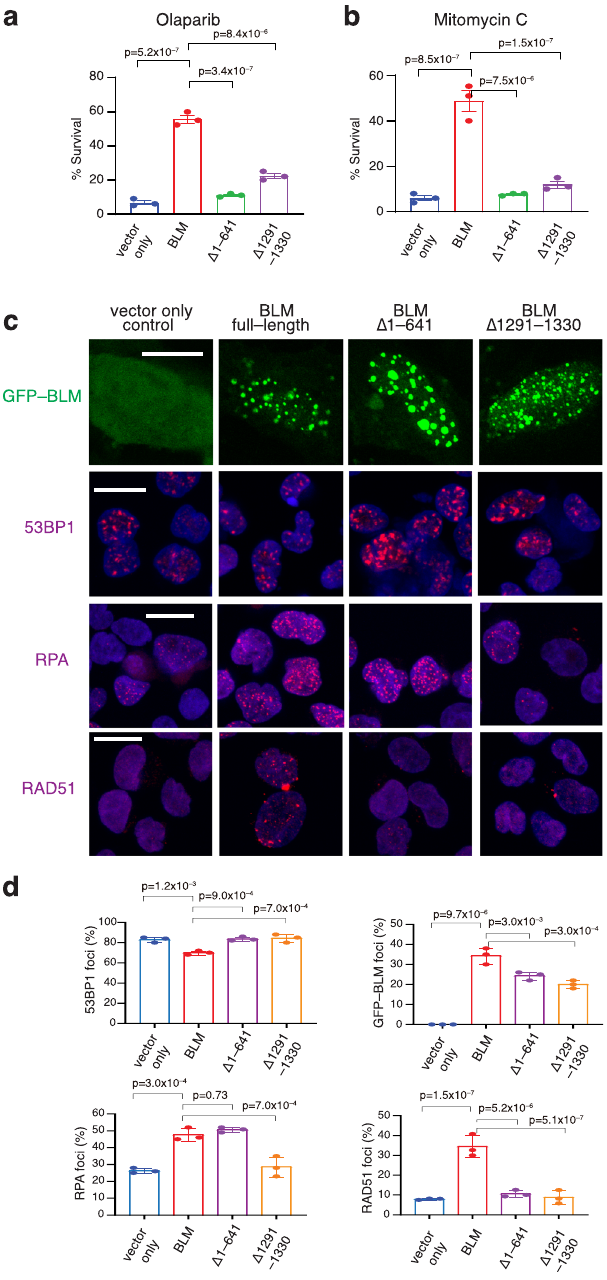
Fig. 7 DNA repair foci defects in cells expressing BLM Δ 1 – 641 and BLM Δ 1291 – 1330 . a Clonogenic survival assays for U2OS cells following double siRNA knockdown of BLM and EXO1 expressing either no BLM (vector only control), full-length GFP-BLM, GFP-BLM Δ 1 – 641 or GFP- BLM Δ 1291 – 1330 , as indicated, after treatment with 17 nM Olaparib (the IC50 for U2OS cells expressing full-length GFP-tagged BLM). Data points represent the mean ± SEM of three independent experiments. b Clonogenic survival assays (as above) following treatment with 12 nM (the IC50 for U2OS cells expressing full-length GFP-tagged BLM) Mitomycin C. Data points represent the mean ± SEM of three independent experiments. c Cells were either visualized for GFP-BLM foci or stained with DAPI and immune- stained with antisera against 53BP1, RPA or RAD51, as indicated, 4 h after exposure to 8 Gy ionizing radiation. Scale bar = 15 µ m. d Quantitation of 53BP1, GFP-BLM, RPA and RAD51 foci. Data points represent the fraction (%) of cells (mean ± SEM, N = three independent experiments) with greater than fi ve foci per cell ( ≥ 300 cells were analyzed per